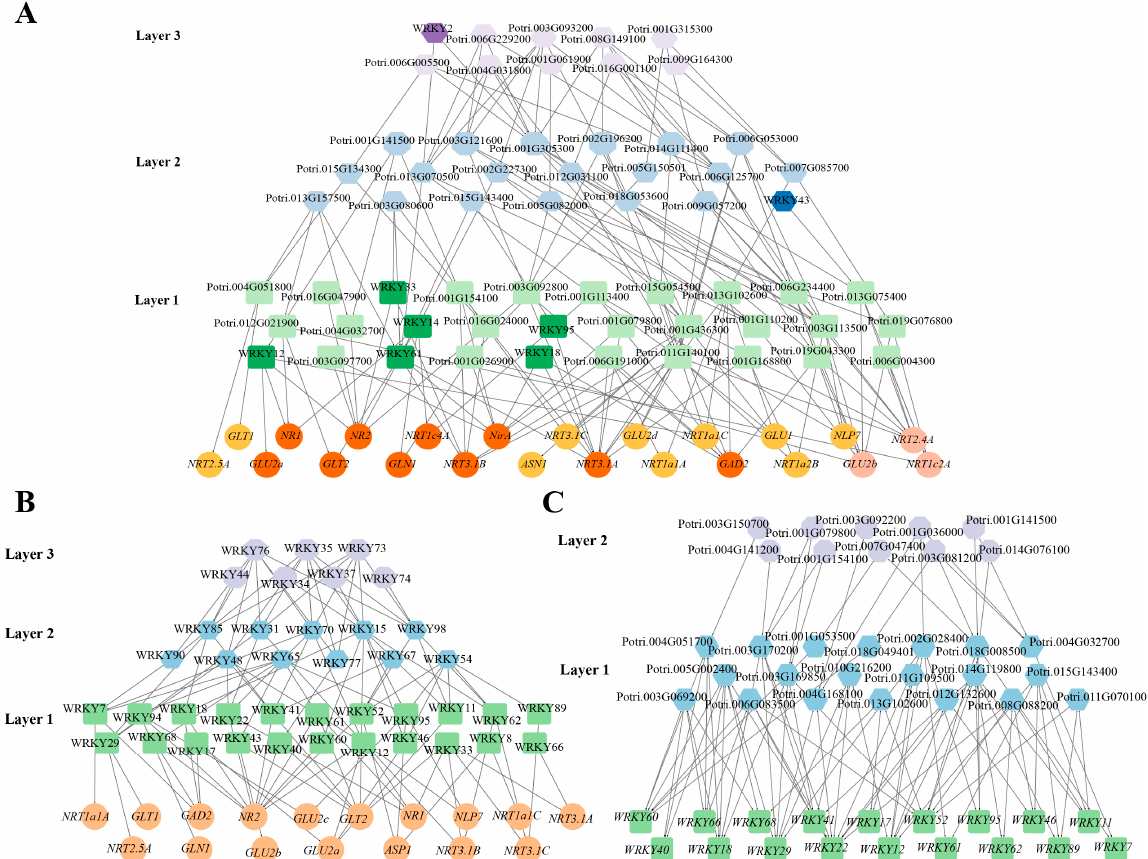
Figure 6. PtWRKYs involved in nitrogen response. Gene network of PtWRKYs regulating NRGs. Gene regulatory network of PtWRKYs response to nitrate. Different layers were distinguished by different colors. The WRKY TFs and the genes it directly regulated were highlighted in darker colors.